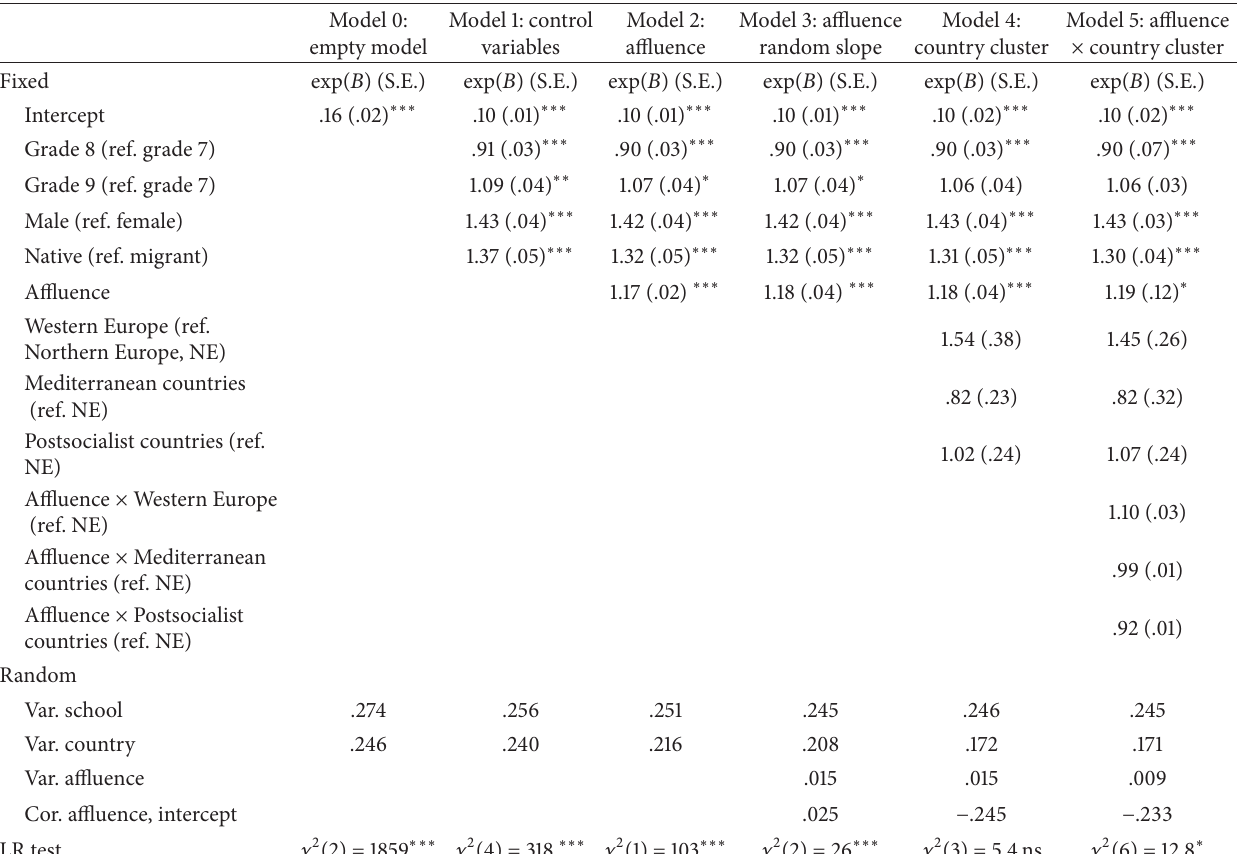
Table 6: The results of multilevel analysis concerning affluence ( 𝑛 individuals: 53136; 𝑛 schools: 1344; 𝑛 countries: